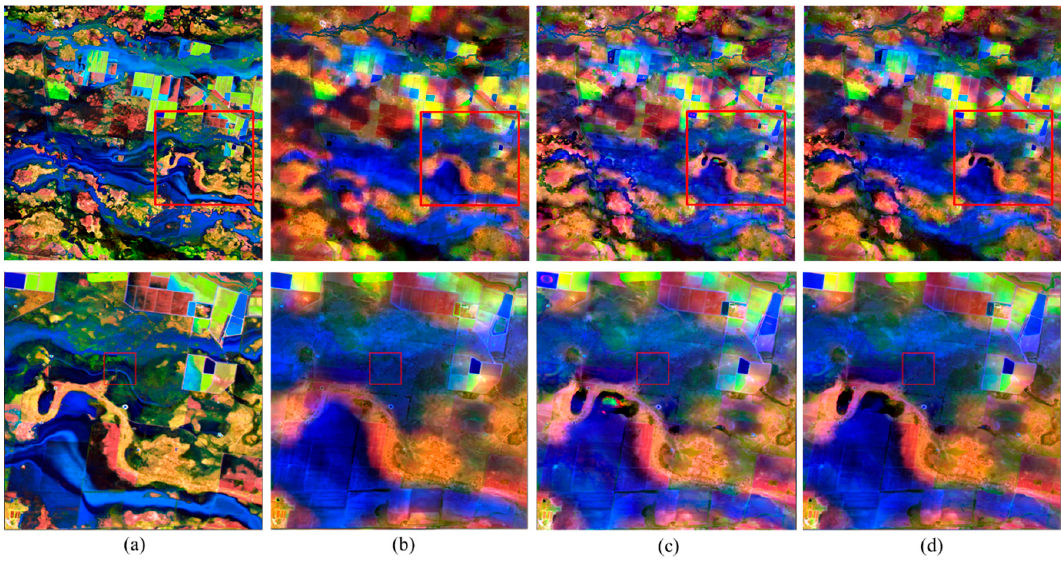
Figure 8. Fusion results on the 8th date of the CIA site. Top row shows the zoomed ground truth in the red rectangle of Figure 6e and the corresponding fusion results. Bottom row shows the zoomed ROIs in the red rectangle of images in the top row. ( a ) the ground truth Landsat image; ( b ) the fusion result of SRSTF; ( c ) the fusion result of CNNSTF; ( d ) the fusion result of VDCNSTF.